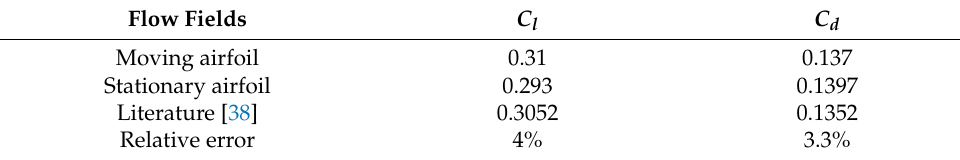
Figure 6. Transverse velocity flow field: ( a ) Moving airfoil; ( b ) Moving airfoil after transformation; ( c ) Stationary airfoil; ( d ) Pressure coefficient comparison. Table 2. Comparison of C l and C d